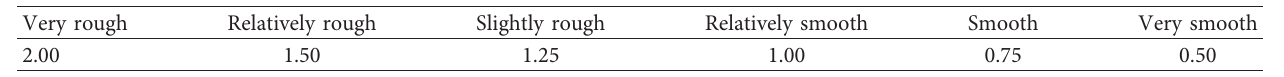
Table 2: Characterization and rating of joint microsmooth coefficients J